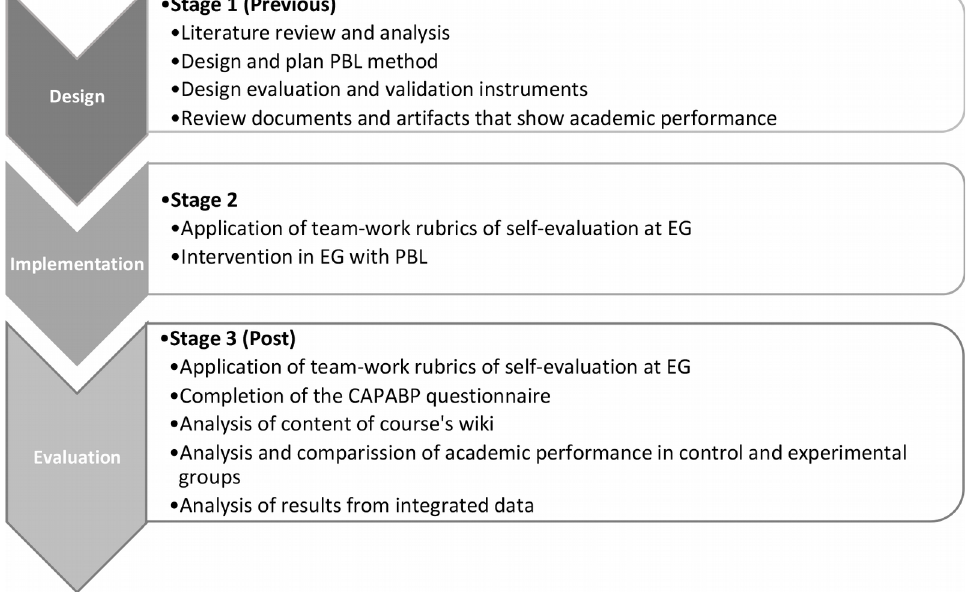
Figure 1. Research design